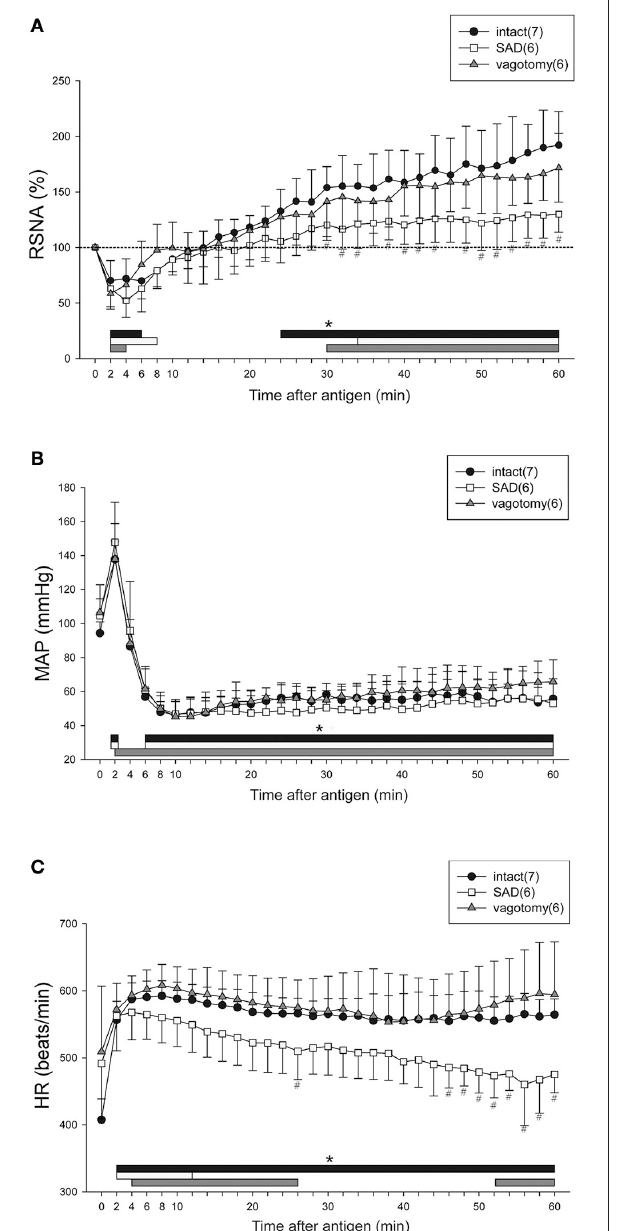
FIGURE 2 | Renal sympathetic and cardiovascular responses to anaphylactic hypotension in the intact, vagotomized, and SAD mice. Summary of the changes in RSNA (A) , MAP (B) , and HR (C) after antigen injection in the intact mice ( • ), vagotomized mice ( N ), and SAD mice ( (cid:3) ). The numbers of mice used are given in parentheses. Values are expressed as means ± SD. # P < 0.05 vs. the intact mice. * P < 0.05 vs. the baseline; the black bar, white bar and gray bar show the significant changes in intact mice, SAD mice and vagotomized mice, respectively. peak response of HR 37 ± 16 beats/min, 1 RSNA/ 1 MAP = − 1.2 ± 0.4, 1 HR/ 1 MAP = − 0.77 ± 0.33, SNP-TRPV1 − / − mice; peak response of RSNA 206 ± 37%, peak response of MAP − 41 ± 5 mmHg, peak response of HR 41 ± 21 beats/min, 1 RSNA/ 1 MAP